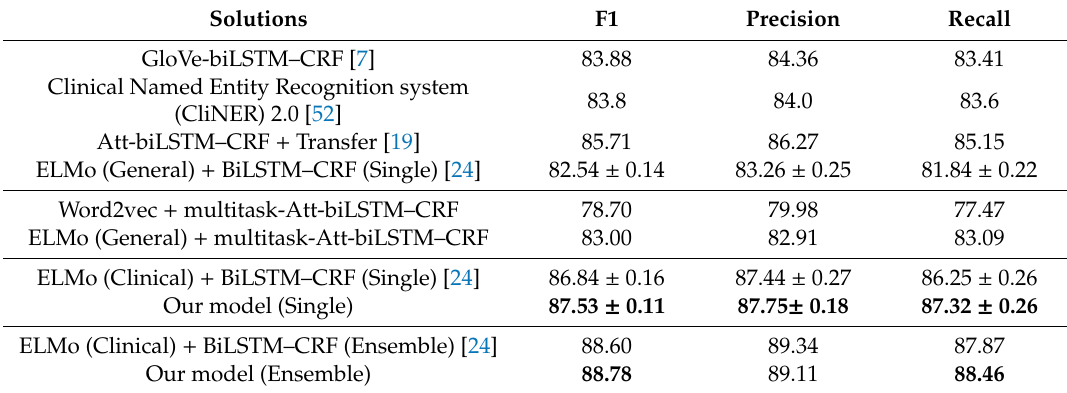
Table 3. Results of experiments on the 2010 i2b2 / VA